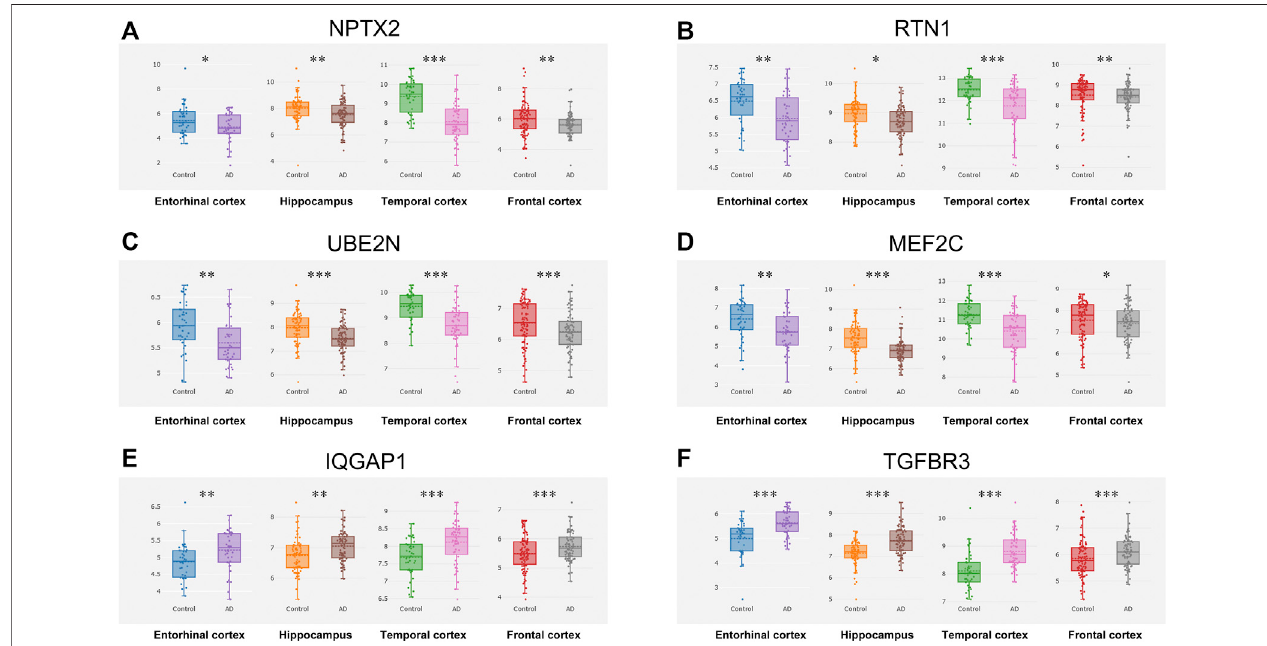
FIGURE 3 | Expressioncross-validationofthecandidategenesinAlzDatadatabase (A) NPTX2 (B) RTN1 (C) UBE2N (D) MEF2C (E) IQGAP1 (F) TGFBR3.* p < 0.05, ** p < 0.01, *** p < 0.001.